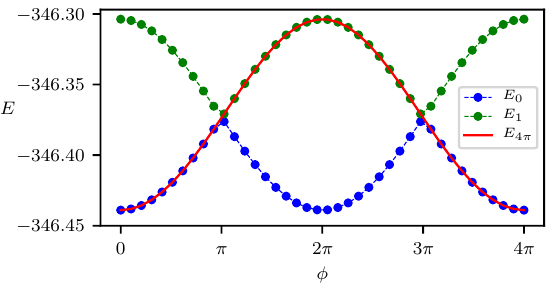
; blue dashed line), and the first excited 0 = 2. The approximate crossings c